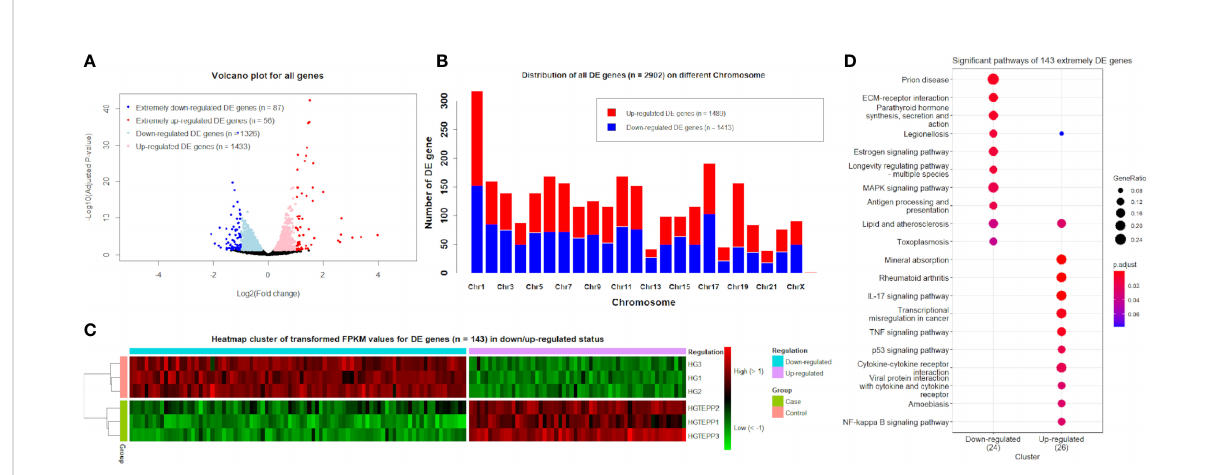
FIGURE 1 Identi fi ed differentially expressed (DE) genes. (A) Volcano plots for all genes based on log 2 (FC) values and adjusted P -values. Genes with thresholds of adjusted P -value ≤ 0.05 are identi fi ed as DE genes, while genes with thresholds of adjusted P -value ≤ 0.05 and |log 2 (FC)| ≥ 1 are identi fi ed as extremely DE genes. (B) Distribution of DE genes ( n = 2,902) on different chromosomes. (C) Heat map cluster for DE genes ( n = 143) in downregulated and upregulated status. The colors from green to red indicate the gene expression levels from low to high after the transform of log 10 (FPKM + 1). HGTEPP1, HGTEPP2, and HGTEPP3 indicate the three replicate samples in the case groups that were treated with 10 m M TEPP-46 in 25 mM HG medium, while the rest of the three samples are in the control groups that were treated without TEPP-46 in 25 mM HG medium. (D) Signi fi cant pathways for extremely DE genes ( n = 143) under the downregulated and upregulated